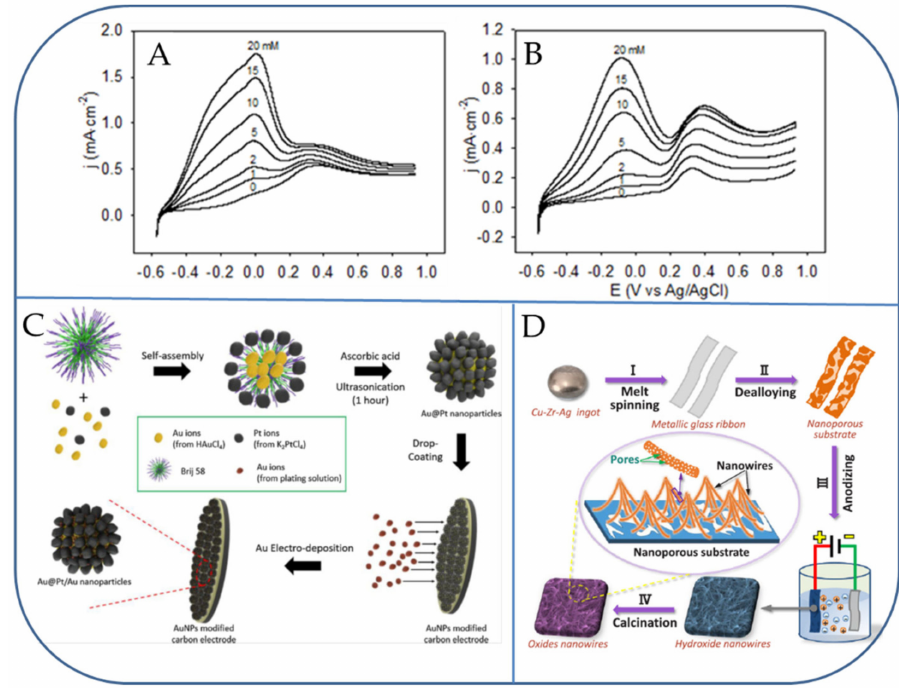
Figure 1. CVs of nanoporous Pt-Pb (50%) electrode at a scan rate of 10 mV s − 1 in 0.1 M phosphate buffer (pH 7.4) solution containing glucose (at concentrations of 0, 1, 2, 5, 10, 15, 20 mM) and ( A ) in the absence of NaCl and ( B ) in the presence of 0.15 M NaCl. Schematic display showing the fabrication of core-shell structured Au@Pt Au NPs ( C ), and free-standing Cu x O/Ag 2 O@NP-CuAg bimetallic electrode ( D ) for glucose detection. Reproduced with permission from Refs.